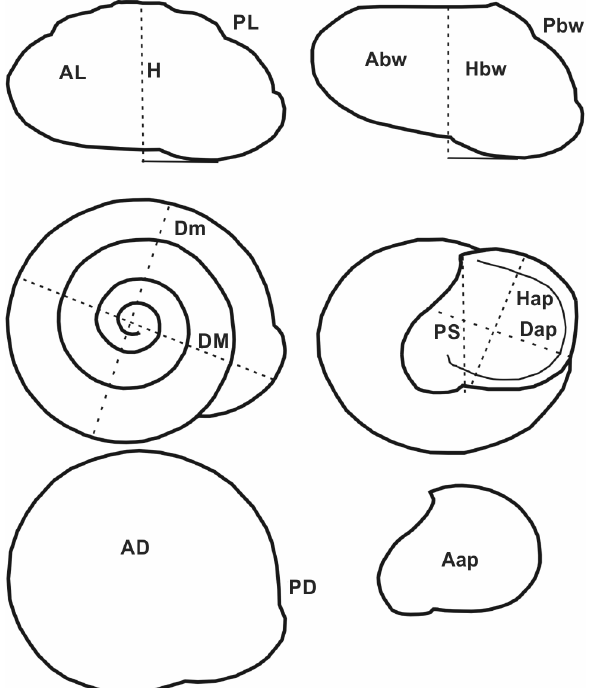
Figure 1. Shell measurements. Abbreviations (AD) dorsal view area, (Aap) apertural area, (Abw) body whorl area, (AL) lateral view area, (Dap) apertural diameter, (DM) major diameter, (Dm) minor diameter, (H) total shell height, (Hap) height of aperture, (Hbw) body whorl height, (Pbw) body whorl perimeter, (PD) dorsal view shell perimeter, (PL) lateral view shell perimeter, (PS) parietal